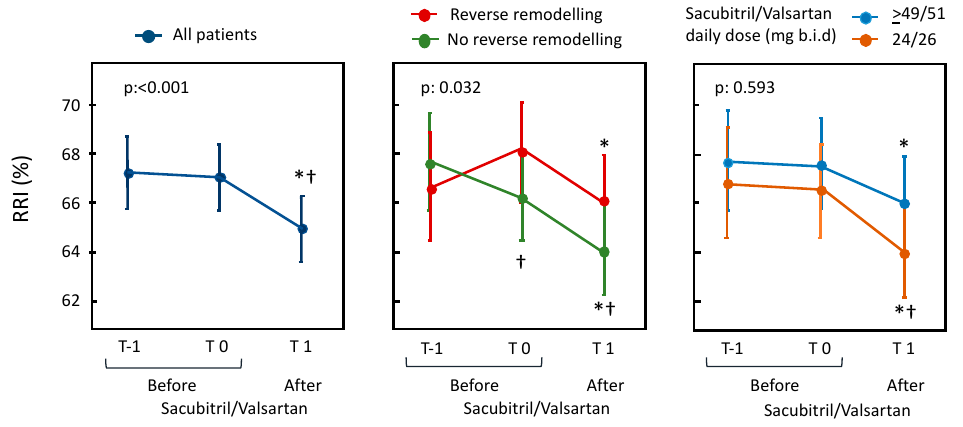
Figure 1. In the left panel, changes in RRI before and after sacubitril/valsartan are presented. In the right panels, changes are presented depending on the occurrence of reverse remodeling after treatment with sacubitril/valsartan and on its dosage. The data are expressed as the mean and 95% confidence interval with a linear mixed model adjusted for repeated measures. p refers to the statistical significance of the model; * p < 0.05 vs. T0, † p < 0.05 vs. T-1.